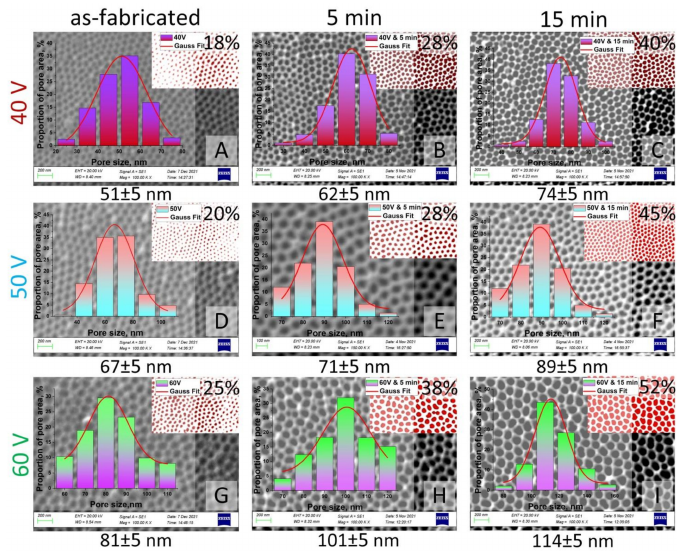
Figure 7. SEM images (contrast SEM images of porosity—red and white) and pore size histograms of the II type samples after chemical modification: ( A )—Sample No. 4 as-fabricated; ( B )—Sample No. 4 after chemical etching during 5 min; ( C )—Sample No. 4 after chemical etching during 15 min; ( D )—Sample No. 5 as-fabricated; ( E )—Sample No. 5 after chemical etching during 5 min; ( F )—Sample No. 5 after chemical etching during 15 min; ( G )—Sample No. 6 as-fabricated; ( H )—Sample No. 6 after chemical etching during 5 min; ( I )—Sample No. 6 after chemical etching during 15